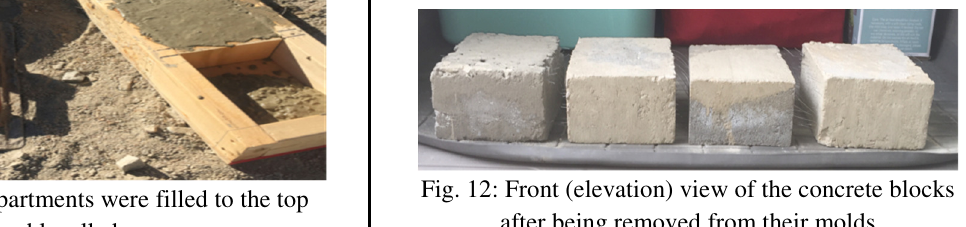
Fig. 12: Front (elevation) view of the concrete blocks after being removed from their